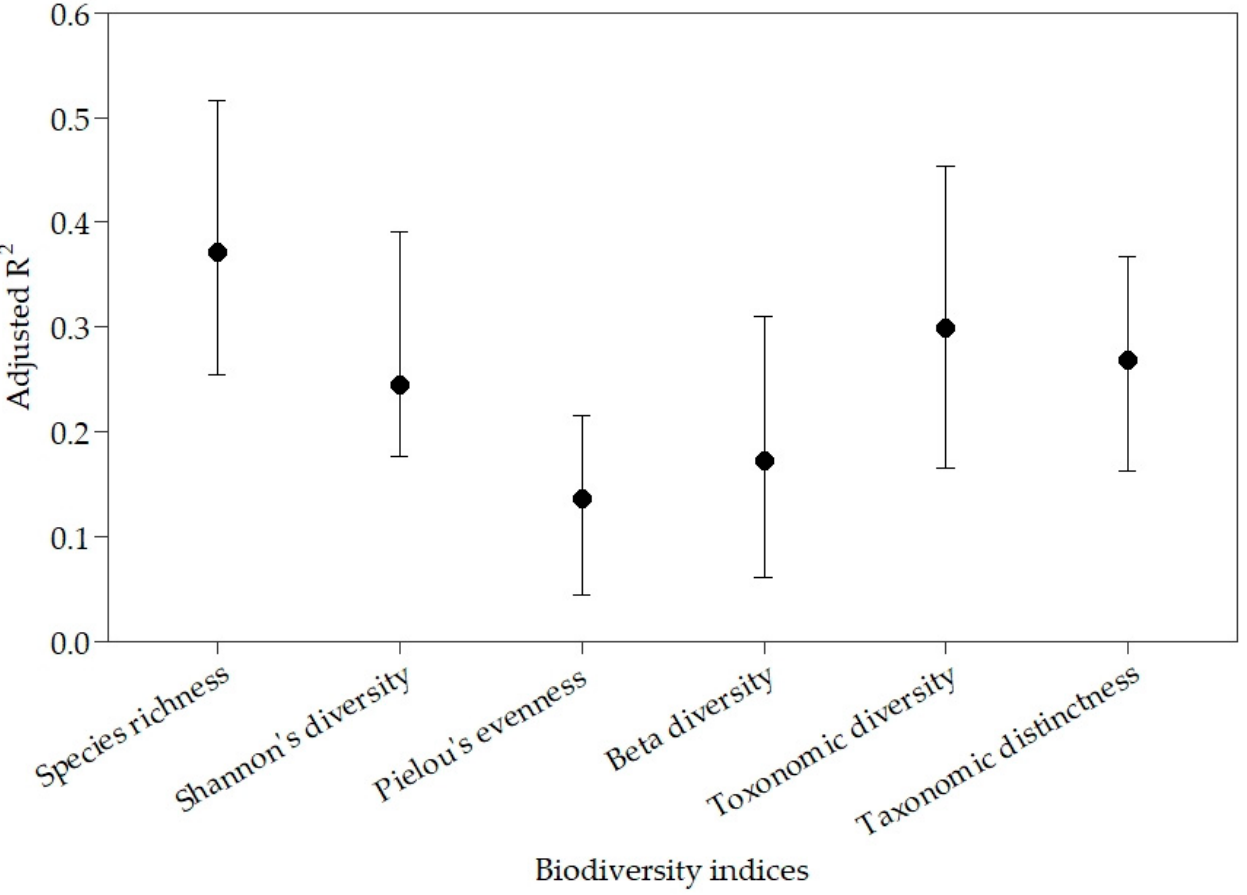
Figure 2. Range in adjusted R 2 values in biodiversity indices across five study freshwater ecoregions from the multiple linear regressions. The dots are mean values with the whiskers representing maximum and minimum values.